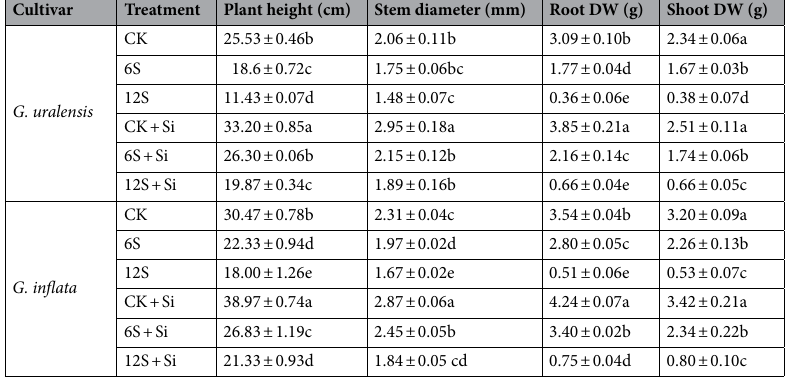
Table 1. Effects of silicon on the growth of Glycyrrhiza uralensis and G. inflata under salt stress. Data are presented as the mean ± SE (n = 3). Different letters indicate significant differences between the values for the same index for the same liquorice species under different treatments (P < 0.05). DW, dry